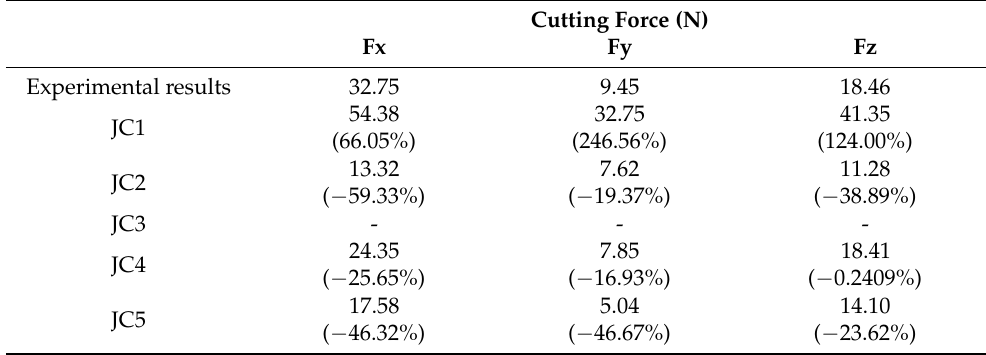
Table 5. Comparison between experimentally and numerically obtained average cutting force (n = 5000 r/min; a p = 0.2 mm, a w = 0.6 mm. Values in brackets are error